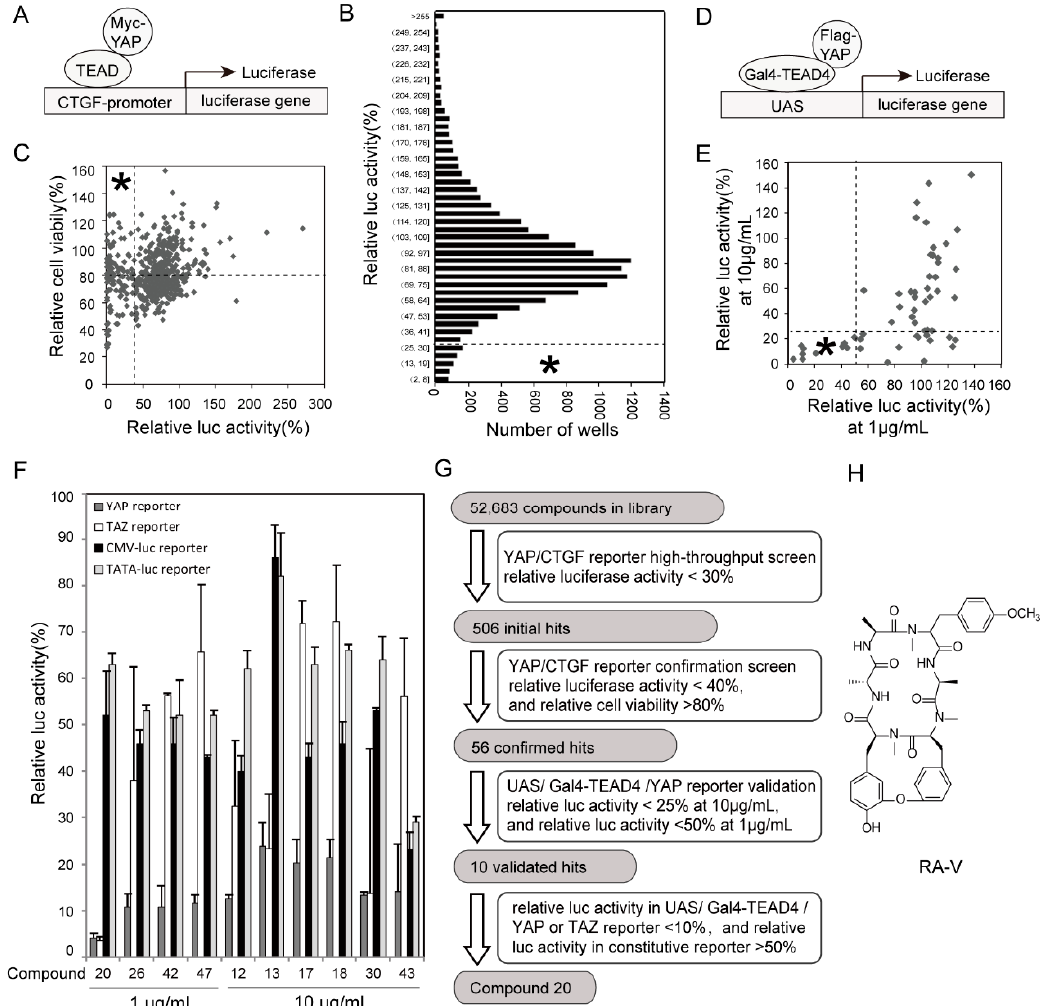
Figure 1. Identification of RA-V as an inhibitor of YAP (Yes-associated protein) reporter. ( A ) Illustration of the CTGF reporter system used in the primary screen. ( B ) Summary of the primary screen. Relative luciferase activities were calculated by normalization to dimethyl sulfoxide (DMSO)-treated control, and the distribution of activities was plotted. Asterisk represents the potion defined as positive. ( C ) Confirming screen using the same reporter assay with additional cell viability assay. Compounds were used at 10 µ g/mL. Asterisk represents the potion defined as positive. ( D ) Illustration of the Gal4-TEAD4/9 × UAS-luciferase reporter assay used in the secondary screen. ( E ) Summary of the secondary screen. Luciferase activity was first normalized with β -galactosidase activity, and then relative activity was calculated by normalization to DMSO-treated control. Asterisk represents the potion defined as positive. ( F ) Validation of Compound 20 as a specific inhibitor of YAP and TAZ reporters. YAP and TAZ reporter assays are similar to that in ( D ). CMV and TATA driven reporters were used as controls. ( G ) Flowchart of the screen. ( H ) Chemical structure of RA-V.